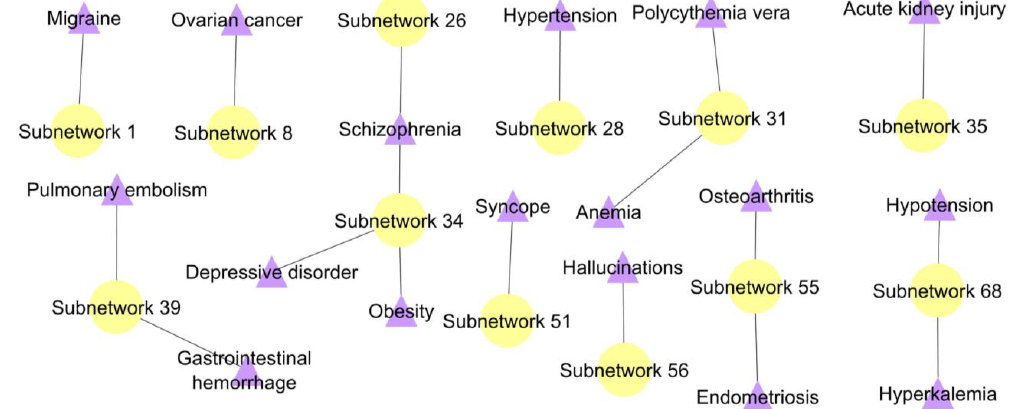
Figure 1. A disease subnetwork highlights significant diseases associated with polycystic ovarian syndrome (PCOS). Shared PCOSrp-enriched subnetworks were evaluated using Fisher’s exact test for their significance. Yellow node represents shared PCOSrp-enriched subnetwork and purple node refers to significant disease. Subnetwork 1 highlighted the association of PCOS with migraine, in which three PCOSrps were which are involved in ribosome